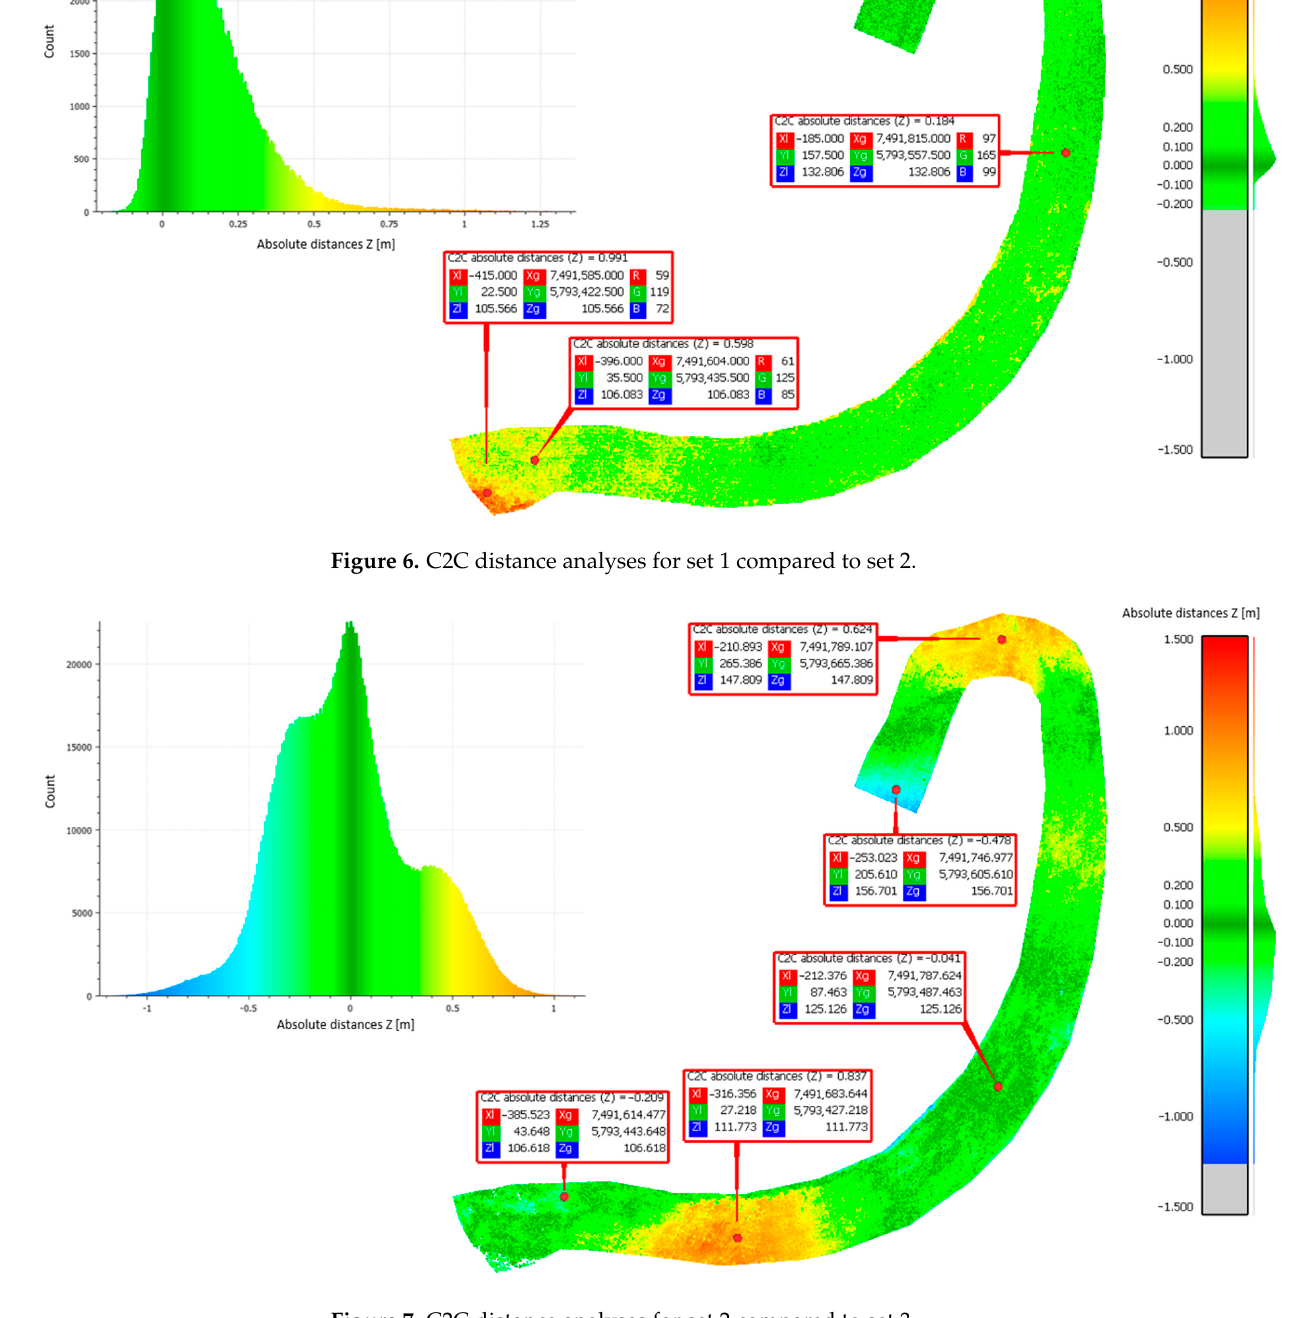
Figure 8. C2C distance analyses for set 3 compared to set 1. Table 3 shows the statistical data calculated using the Gaussian elimination for the mean value of the height differences obtained from the comparison of the different methods, as well as their standard deviation (mean value, standard deviation).